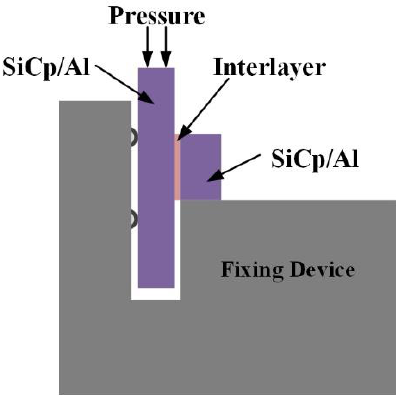
Figure 3. Schematic diagram of the shear test.